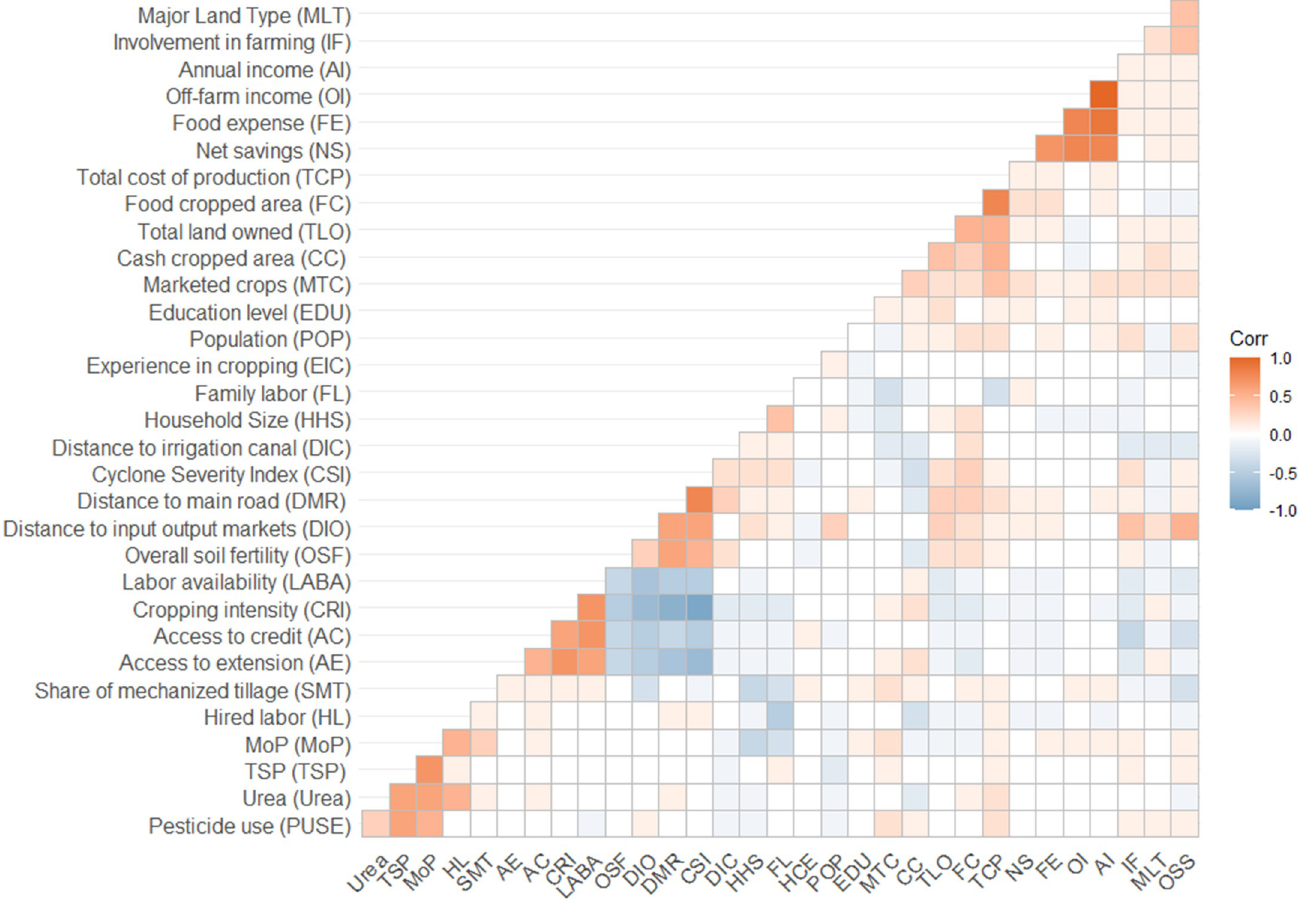
Fig 2. Correlation (corr) matrix of variables collected through smallholder household